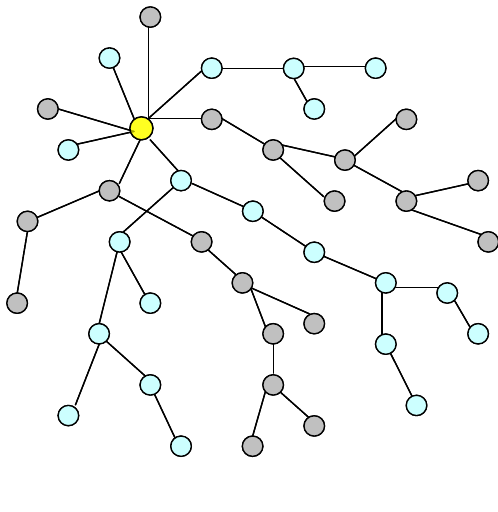
Figure 7. Two disjoint aggregation trees rooted at a base